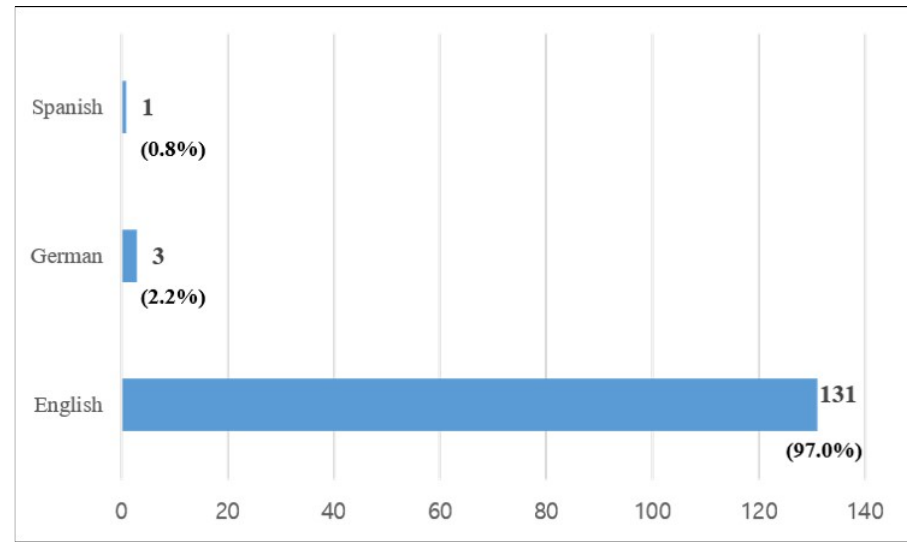
Figure 4. Distribution of the articles by language.